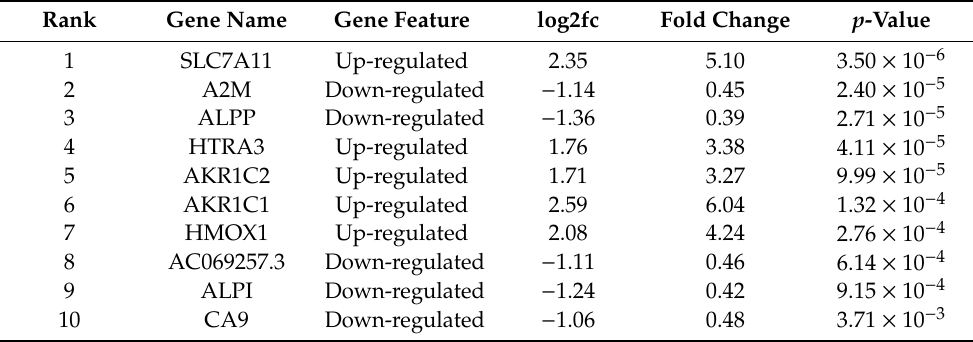
Table 2. Top 10 di ff erentially expressed genes in MGC-803 cells (PEO treatment versus control).